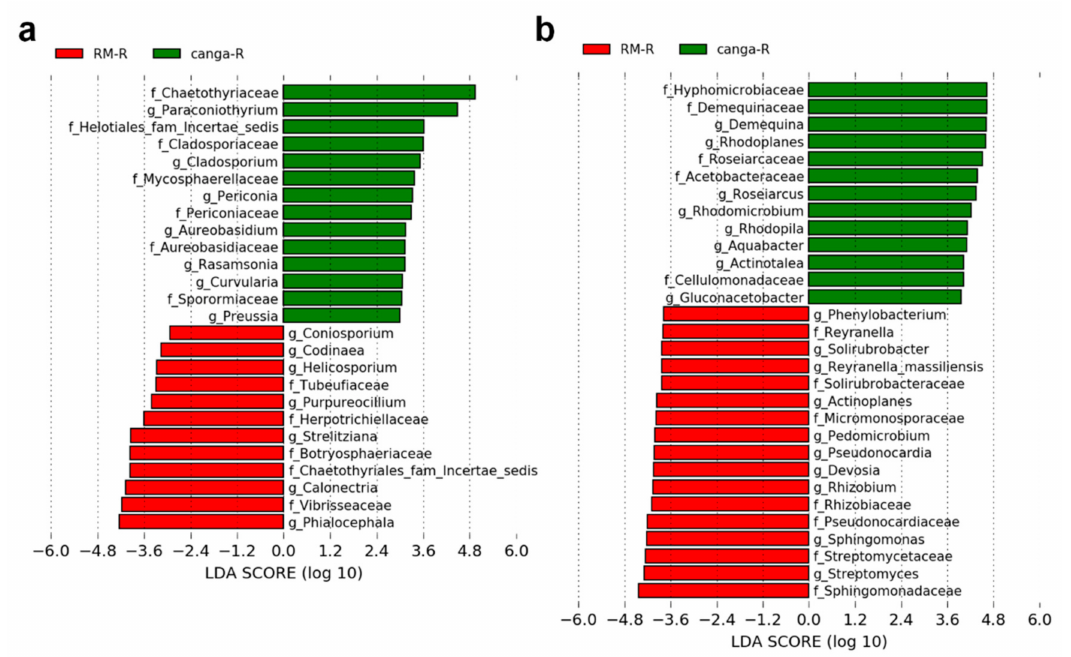
Figure 5. Linear discriminant analysis (LDA) of effect size (LEfSe) to identify preferential taxa in the rhizosphere of plants identified in canga ( canga ) or in the rehabilitating minelands (RM).